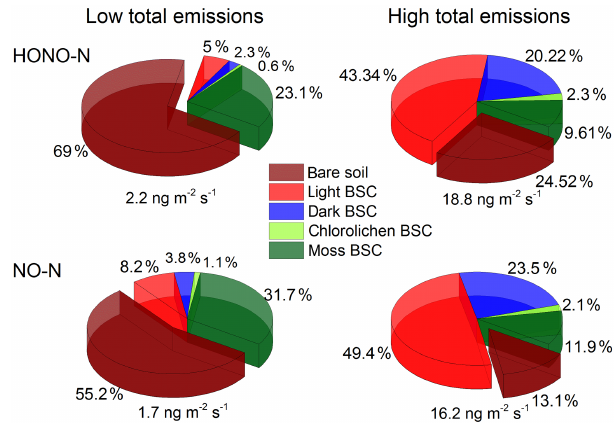
Figure 7. Contributions of different ground surfaces to the total